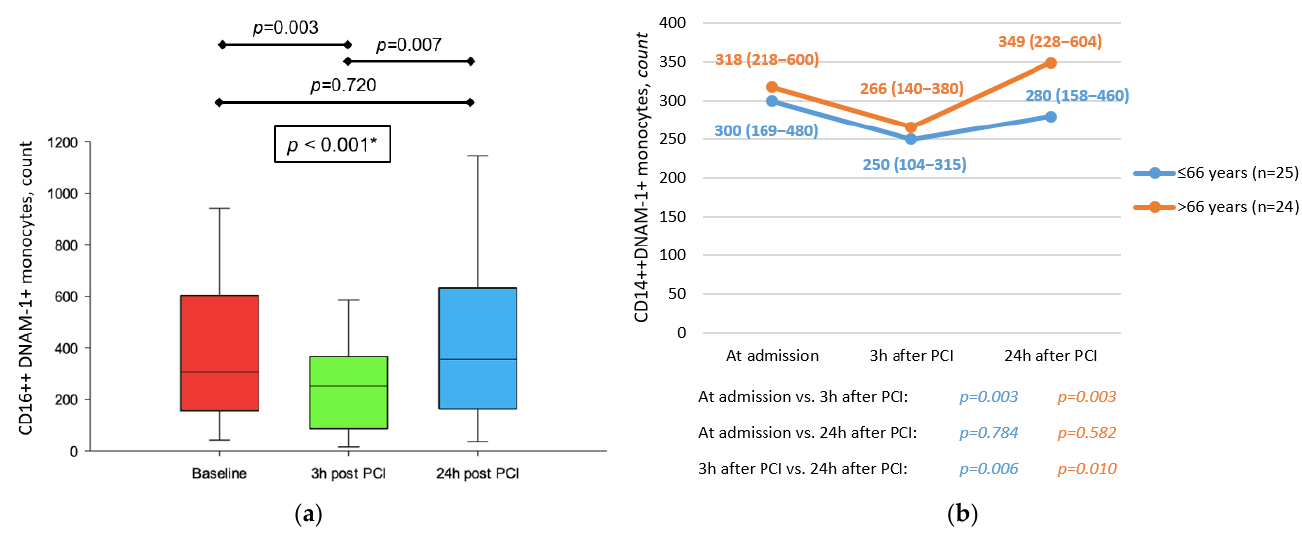
Figure 4. ( a ) Dynamic of CD14++DNAM-1+ monocytes in peripheral blood in patients with STEMI treated with primary PCI. * Friedman test with post hoc Conover test. ( b ) Comparison between dynamic of CD14++CD226+ monocytes in peripheral blood in patients with STEMI treated with primary PCI with respect to age. All data are presented as median (interquartile range).